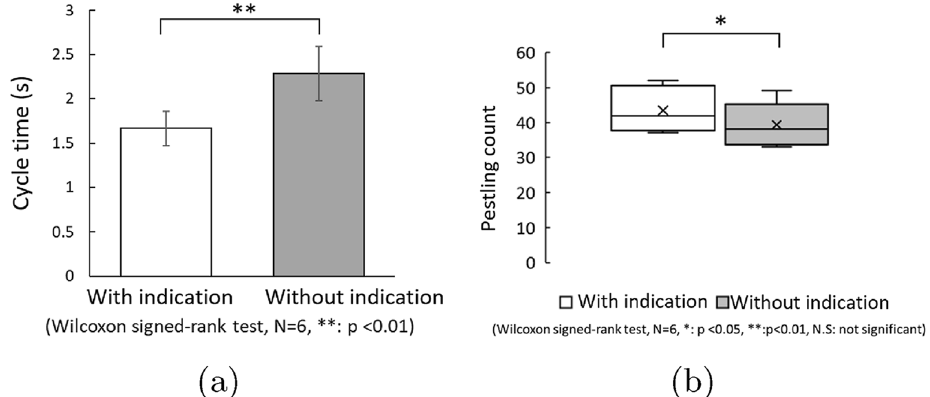
Fig. 9 Performance evaluation results a Cycle time comparison when asked to match a specific pace of 1.666 s . b Difference in number of time the dough was hit within a work